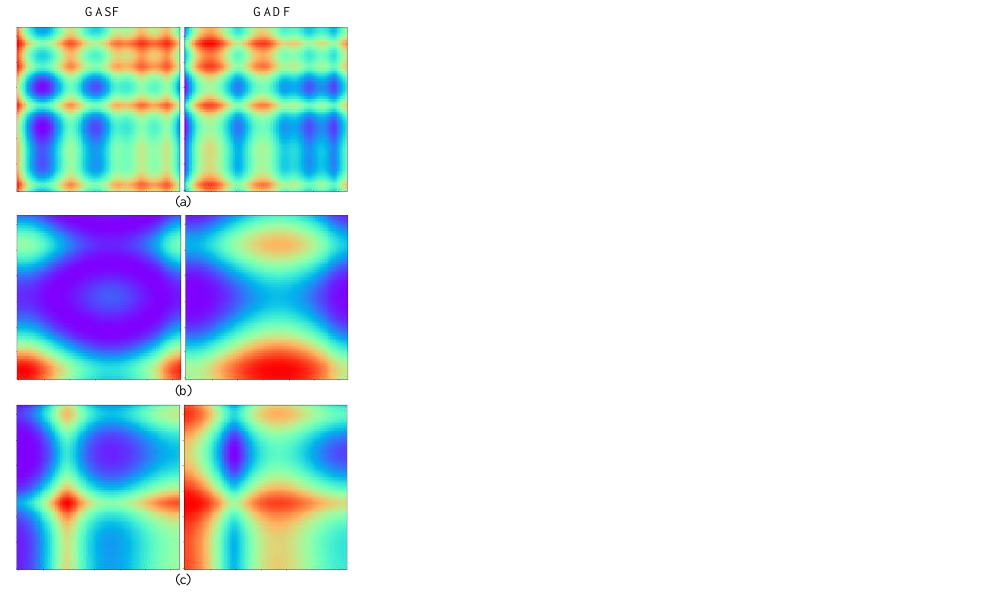
Figure 1. Illustration of GAF image: ( a ) healthy; ( b ) outer ring fault; and ( c ) inner ring fault.